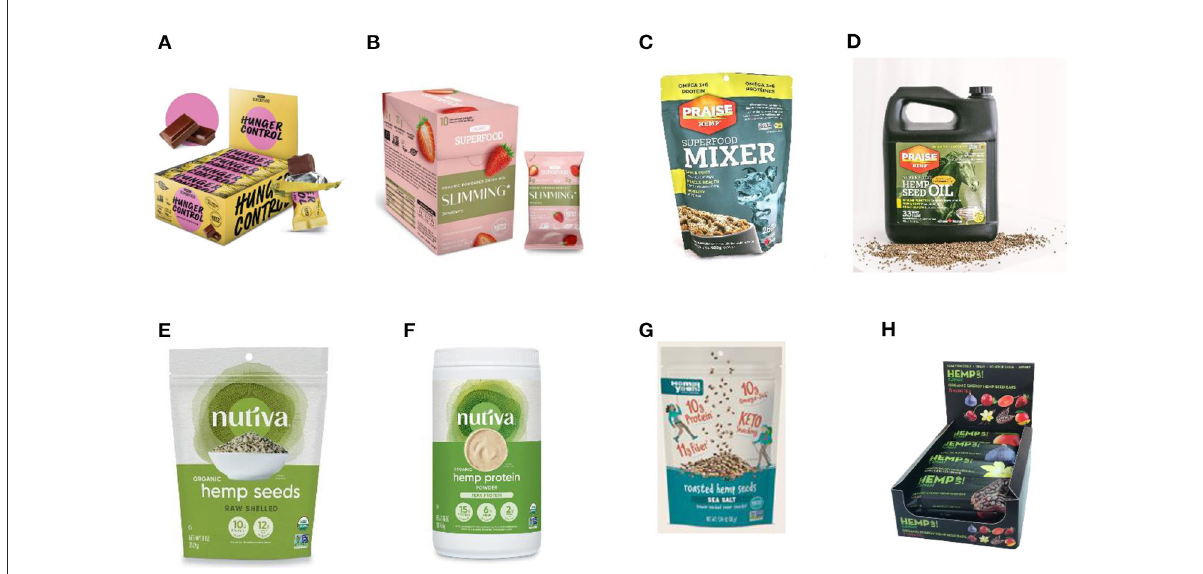
FIGURE5 Food products derived from hemp seeds and hemp seed oil. (A) Hunger & craving control: vegan protein bar ® (Allive ® ) (B) , Slimming protein smoothie: cream strawberry ® (Allive ® ), (C) superfood Mixer ® (Allive ® ), (D) Superfood Hemp seed oil 4L ® (Allive ® ), (E) Organic shelled